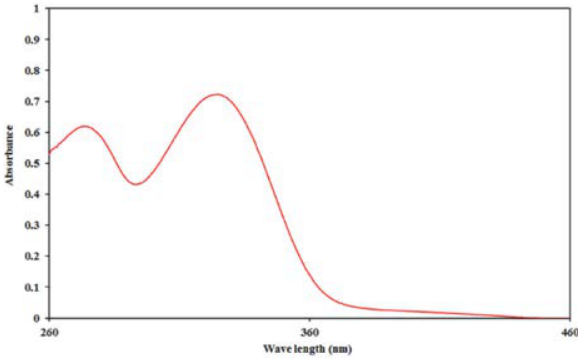
Figure 1. UV absorption spectra of representative complex I in